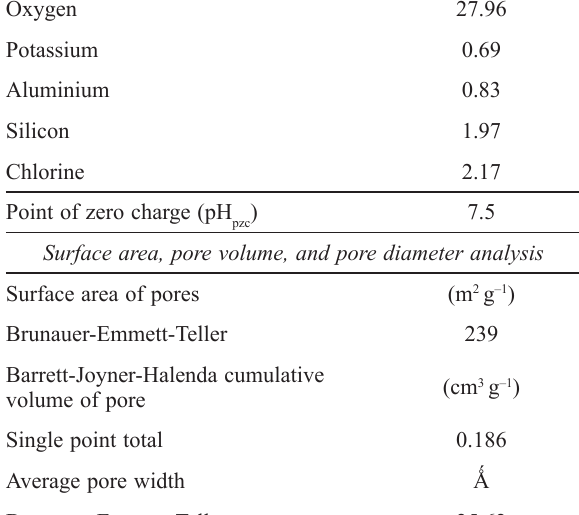
Fig. 2 – (a) Point of zero charge for RSAC, (b) BET hystere- sis and pore characteristics of